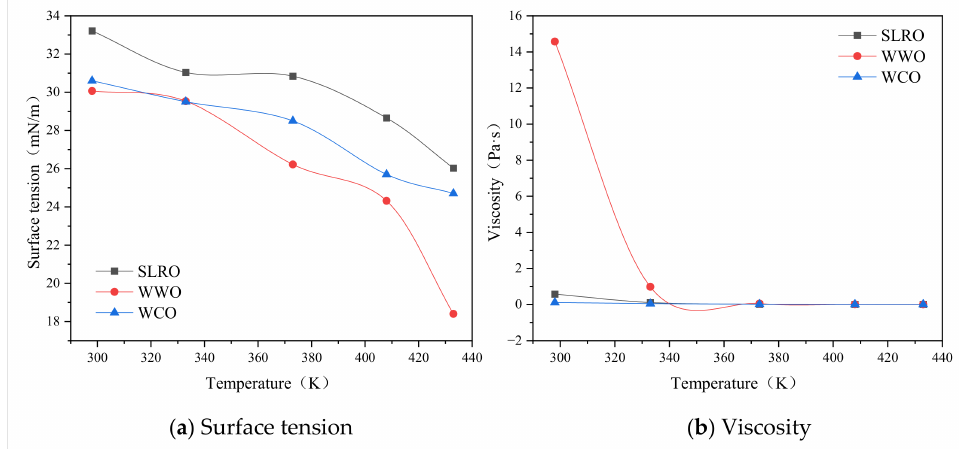
Figure 8. Surface tension and viscosity of bio-oil vary with temperature.